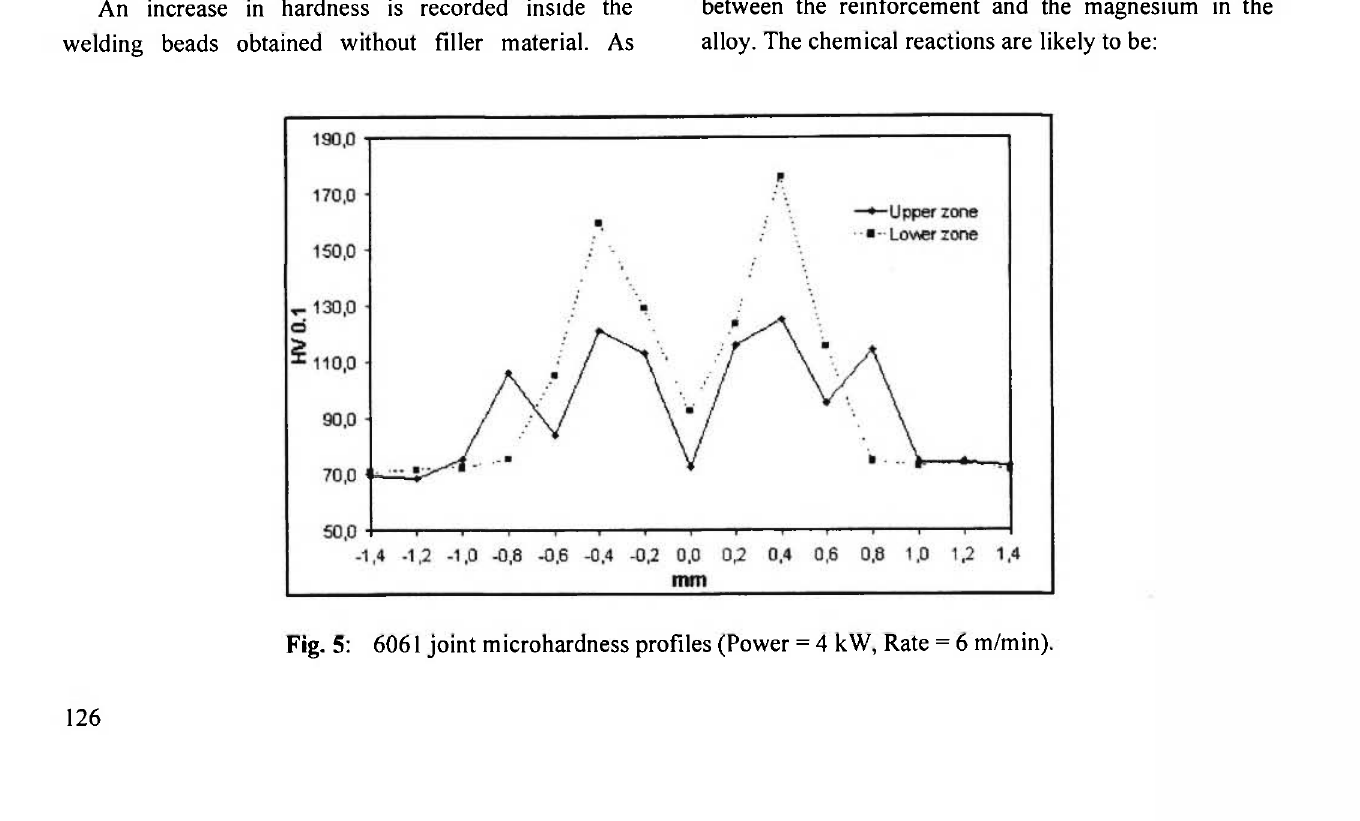
Fig. 4: Welding bead cross sections of a) 6061/20% A1 2 0 3 composite, b) 2618/20% A1 2 0 3 composite, c) 2618/20% A1 2 0 3 composite with filler material. The laser beam power was 4 kW and the feed rate was 6 m/min for the samples a) and b), while it was 4 m/min for the sample c).